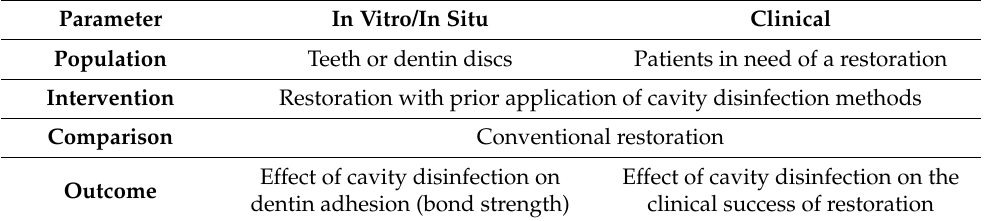
Table 1. Population, Intervention, Comparison and Outcome (PICO) Strategy. Parameter In Vitro/In Situ Clinical Population Teeth or dentin discs Patients in need of a restoration Intervention Restoration with prior application of cavity disinfection methods